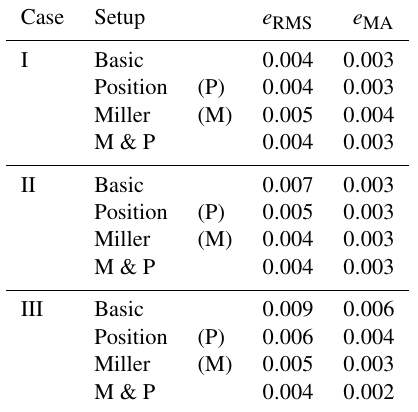
Table 5. In order to analyze the results of the 1-D study, the per- formance of the best ensemble members for each case and for each setup are benchmarked with statistical measures. With increasing numbers of included TDR sensors per material, the statistical mea- sures for the basic setup indicate a worse description of the measure- ment data. However, estimating the position and the Miller scaling factor for each TDR sensor improves the description of the mea- surement data significantly according to the statistical